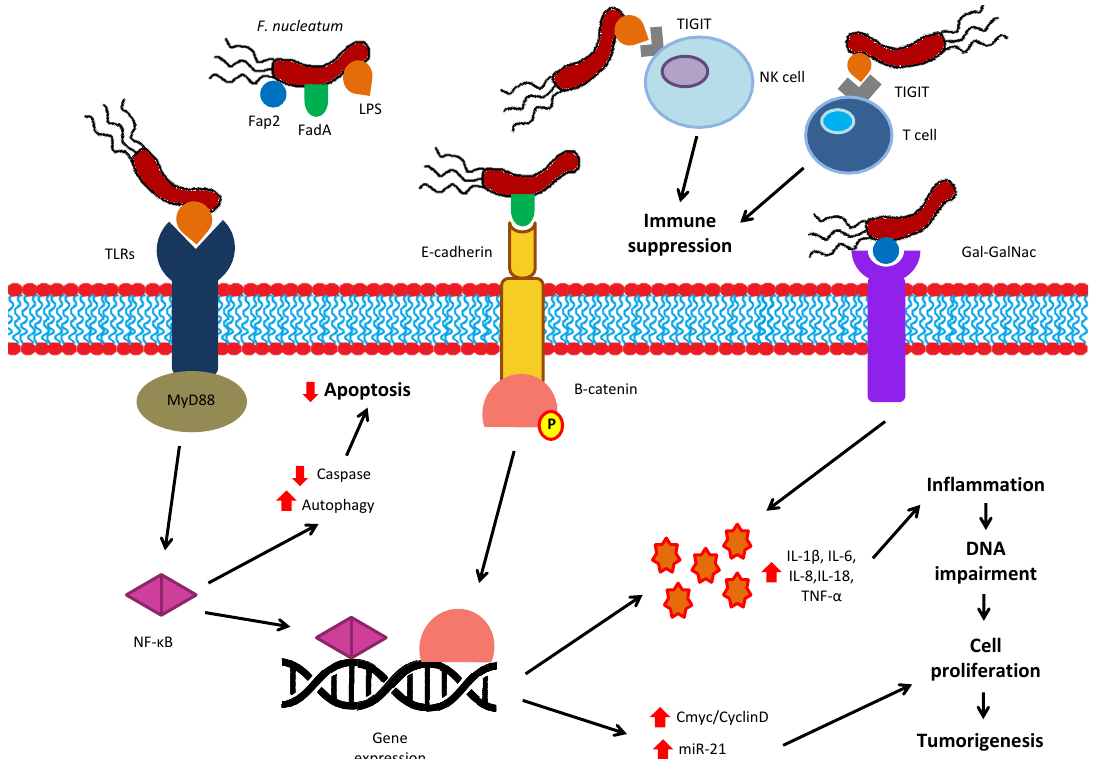
Figure 1. Schematic summary of the molecular pathways of F. nucleatum in CRC tumorigenesis. F. nucleatum mediates its oncogenic properties through three major components: the Fap2, and FadA molecules along with the LPS. LPS can interact with TLRs (namely TLR2 or TLR4), activating the MyD88 and NF- κ B pathway. This interaction leads to reduced caspase activity and increased autophagy, resulting in reduced apoptosis. Furthermore, FadA binds to E-cadherin, causing dephosphorylation and activation of β -catenin. NF- κ B and β -catenin alter the gene expression, increasing the synthesis of pro-inflammatory cytokines (IL-1 β , IL-6, IL-8, IL-18, TNF- α ) and upregulating oncogenic pathways of Cmyc / CyclinD and miR-21. The pro-inflammatory state is further enhanced by the binding of Fap2 to Gal-GalNAc. Additionally, the interaction of LPS with the TIGIT receptor of NK and T cells leads to suppression of anti-tumor immunity. Eventually, these events create inflammation which impairs DNA, promotes cell proliferation and results in CRC tumorigenesis. CRC: colorectal cancer; Gal-GalNAc: D-galactose- β (1–3)-N-acetyl-D-galactosamine; IL: interleukin, LPS: lipopolysaccharide; miR: microRNA: NF- κ B: nuclear factor kappa-beta; NK: natural-killer; TIGIT: T-cell immunoglobulin and immunoreceptor tyrosine-based inhibitory motif domain; TLR: toll-like receptor; TNF- α : tumor necrosis factor-alpha. Upward red arrows: enhancement / stimulation; Downward red arrows: